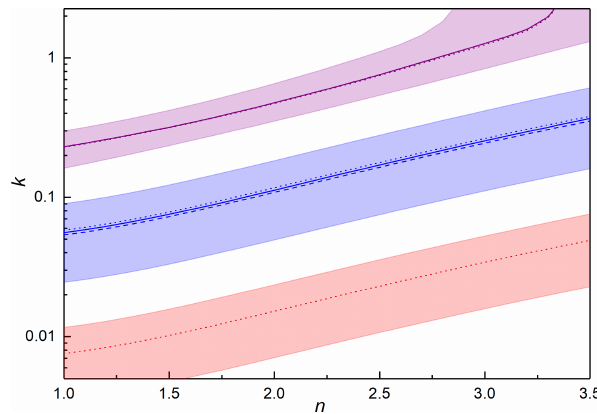
Figure 8. Absorption efficiencies for a range of particle sizes at three different wavelengths: 405nm (purple), 488nm (blue) and 660nm (red). Also shown are the literature data for haematite par- ticles from Querry (1985) (long dash), Hsu and Matijevic (1985) (short dash), Bedidi and Cervelle (1993) (dot dash), Longtin et al. (1988) (dotted), and the average (bold lines).